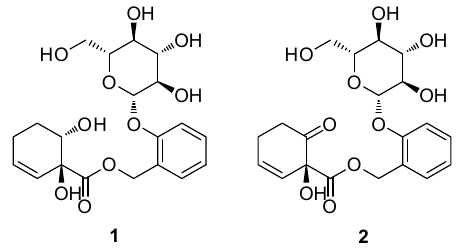
Figure 2. Chemical structure of salicortinol ( 1 ) and salicortin ( 2 ).